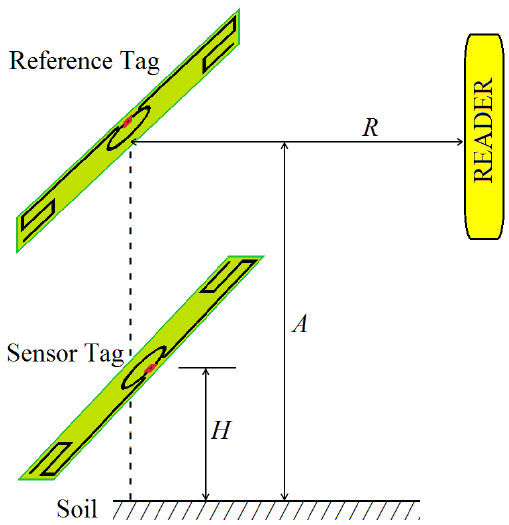
Figure 1. System using two adhesive UHF RFID tags for soil moisture monitoring. Sensor and reference tags, with distance H and A , respectively, from soil. The reading distance is R .